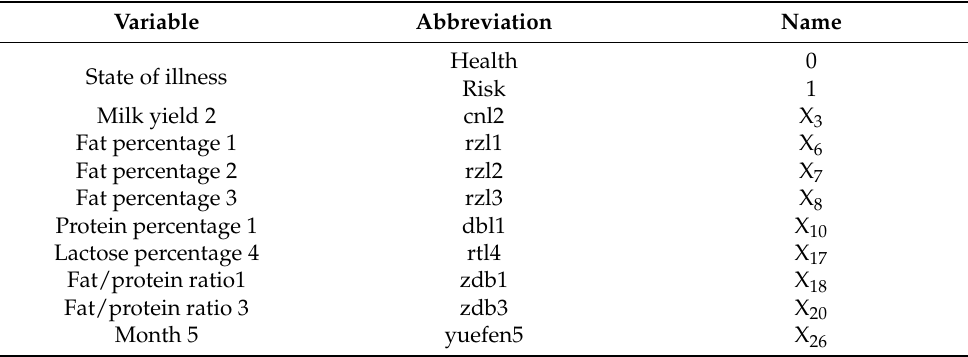
Table 4. Risk factors of mastitis in Chinese Holstein cattle in the Beijing area.